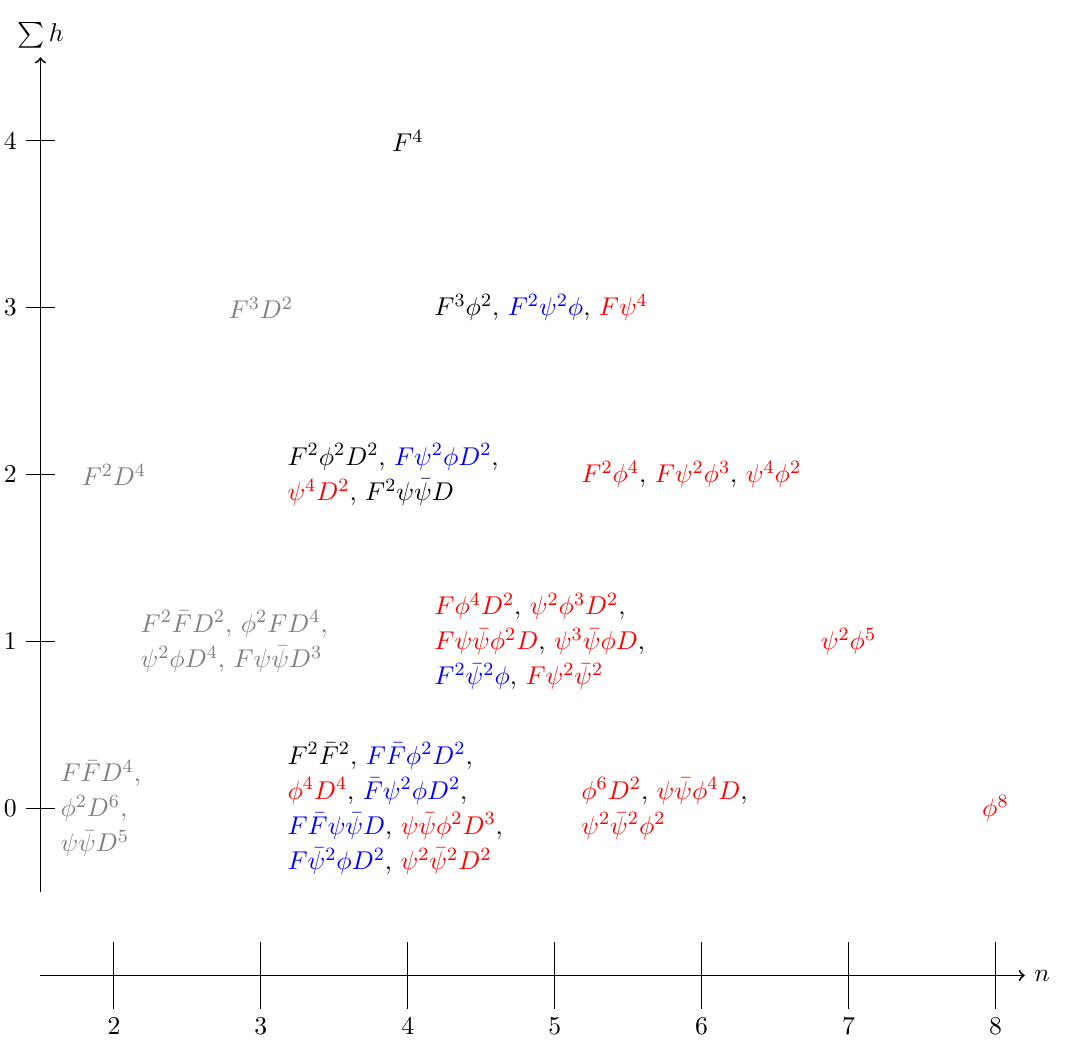
Figure 2 . The classes of dimension eight operators. Operators in red arise at tree level in a weakly coupled renormalizable UV completion, as de(cid:12)ned in section 3. Operators in blue and black are generated at loop level, but only those in blue are renormalized by tree-level operators. Those in gray can be expressed in terms of the others by equations of motion, when considering their e(cid:11)ects in helicity